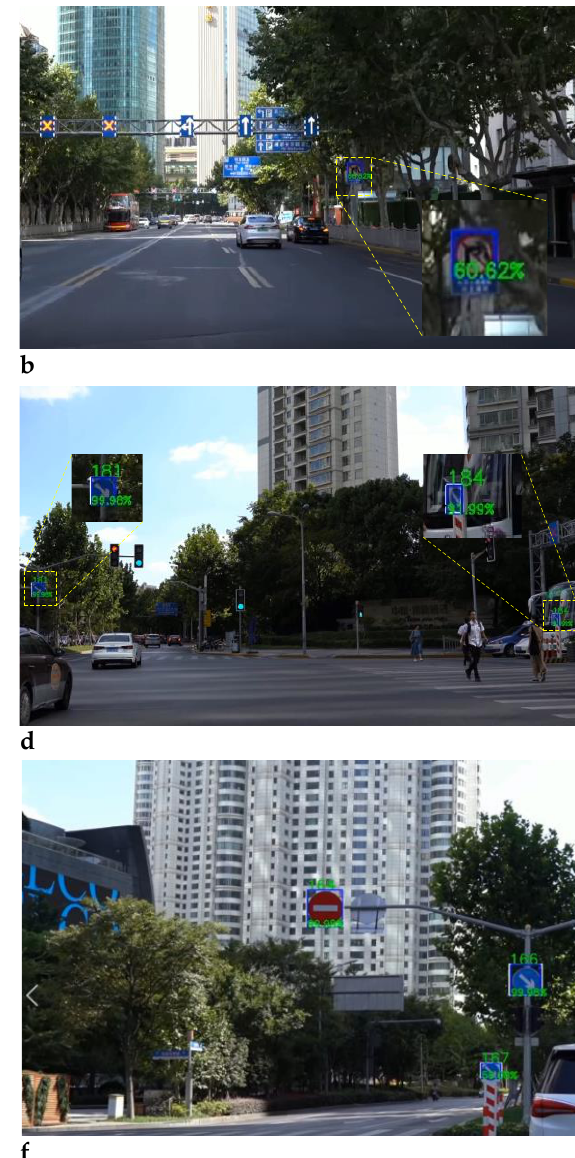
Figure 7. The left column ( a , c , e ) show the original video detection results, and the right column ( b , d , f ) show the video detection results after adding Deep-Sort.